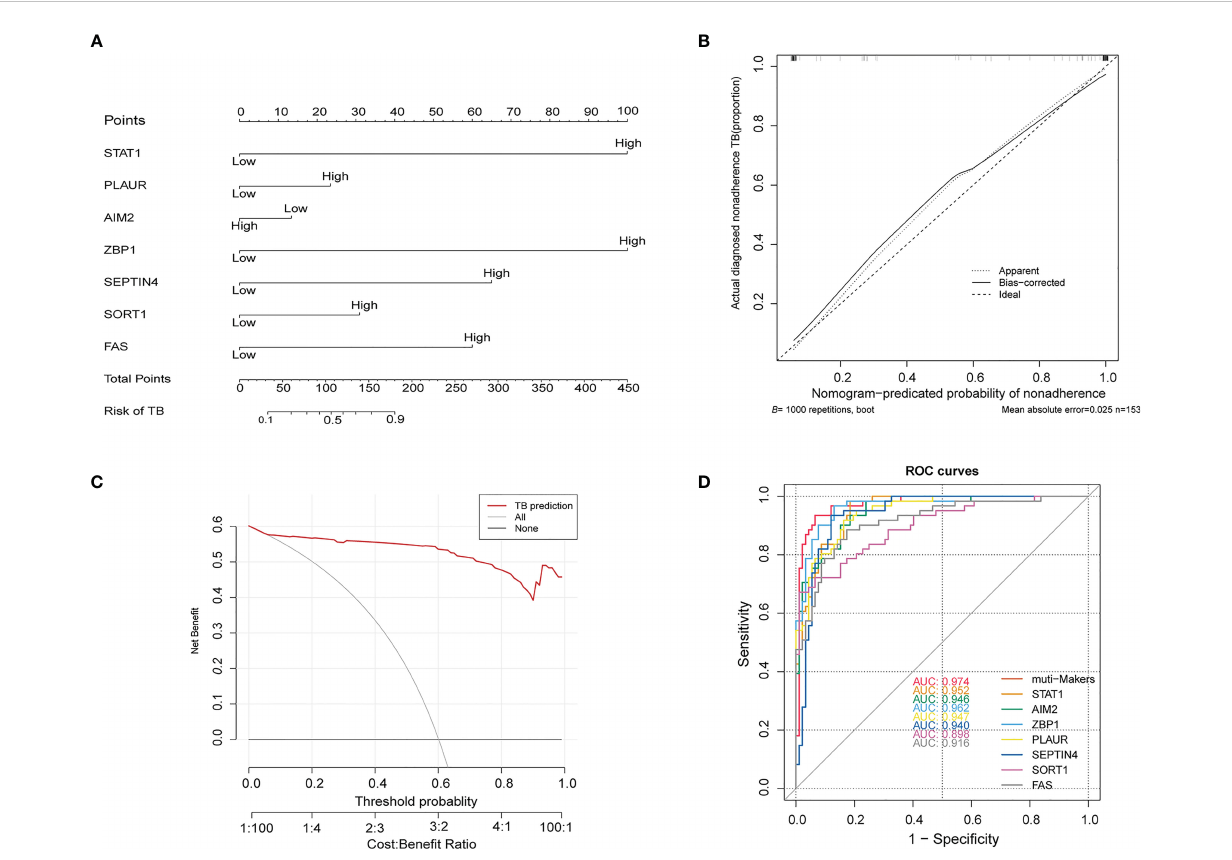
FIGURE 6 (A) Construction of a nomogram model based on seven PCD-related genes. (B) Calibration plot assessing the robustness of nomogram predictions. (C) Decision curve analysis for the established nomogram. (D) ROC curve of the PCD-related signature when used for the diagnosis of TB. ROC, receiver operating